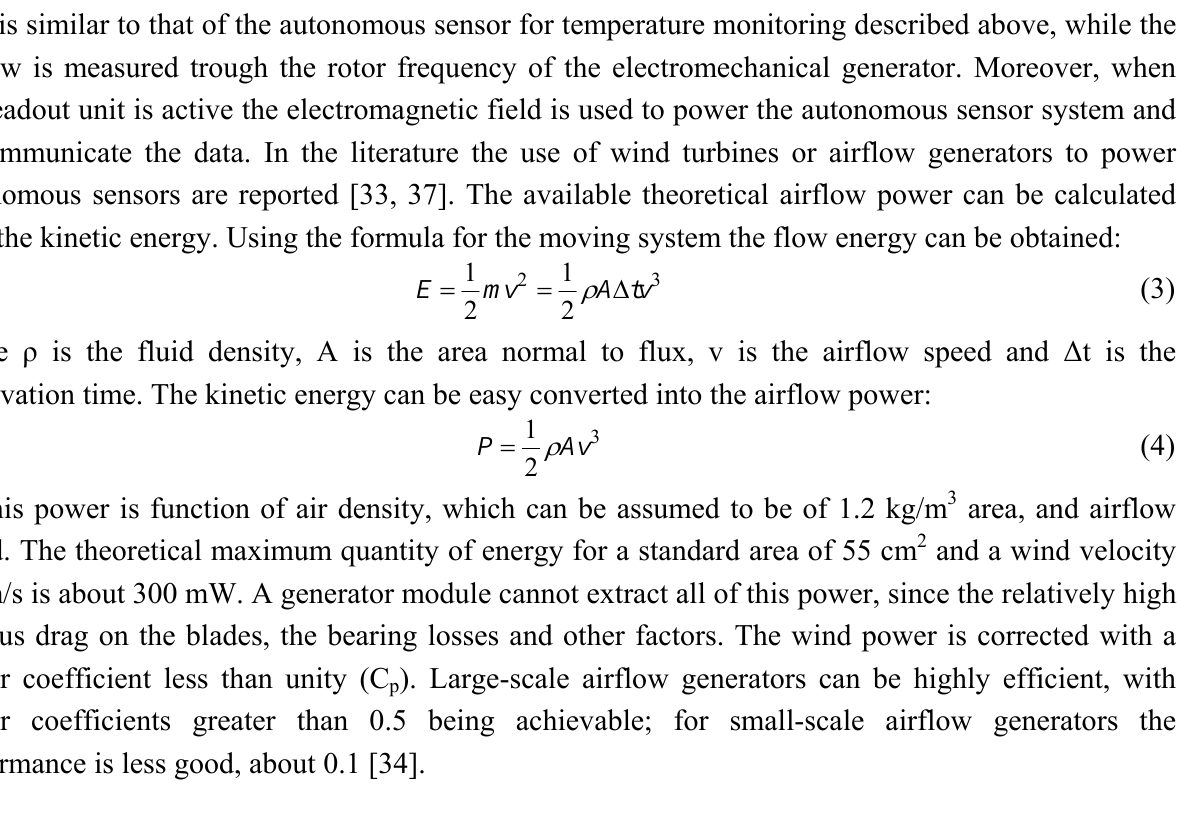
Figure 12. (a) The experimental set-up of the self-powered autonomous sensor for flow measurement and (b) the block diagram of the autonomous sensor and readout